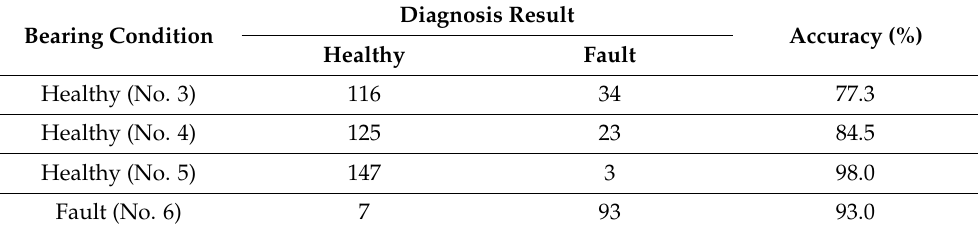
Table 7. Diagnosis result based on Neural